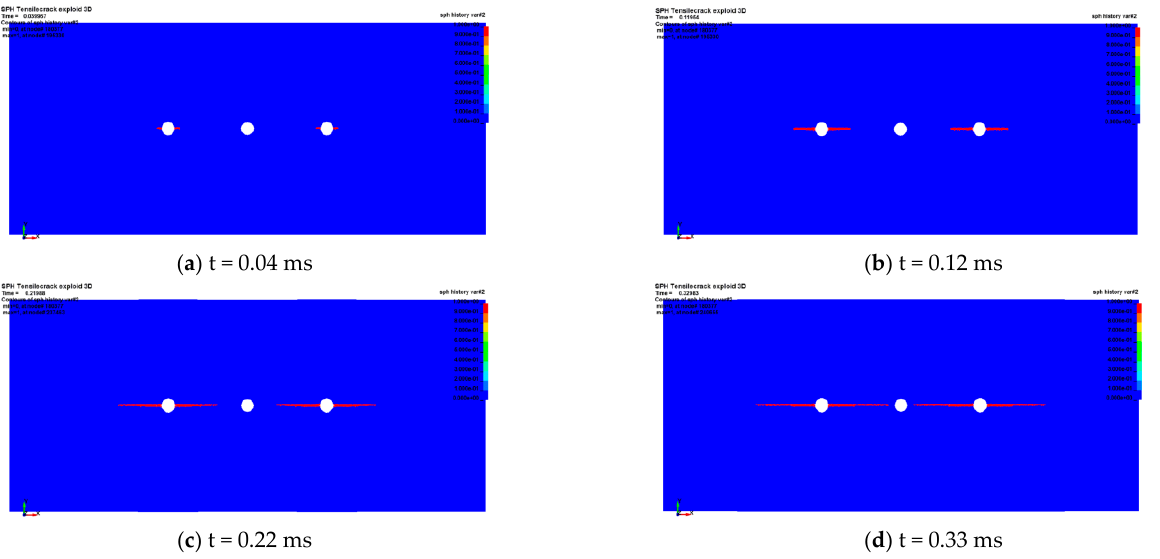
Figure 30. Stress evolution process of spaced-hole blasting with 300 mm spacing.